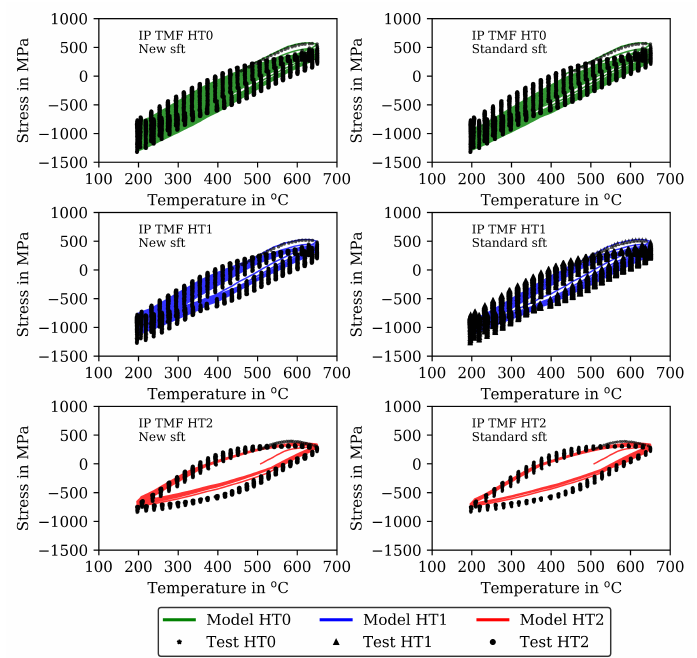
Figure 9. Stress–temperature diagrams for the measured stress and stress calculated with the vis- coplasticity model for the in-phase TMF tests for the HT0, HT1, and HT2 material (mechanical strain amplitude of 0.005). New isotropic-softening model ( left ) and standard isotropic-softening model ( right ).